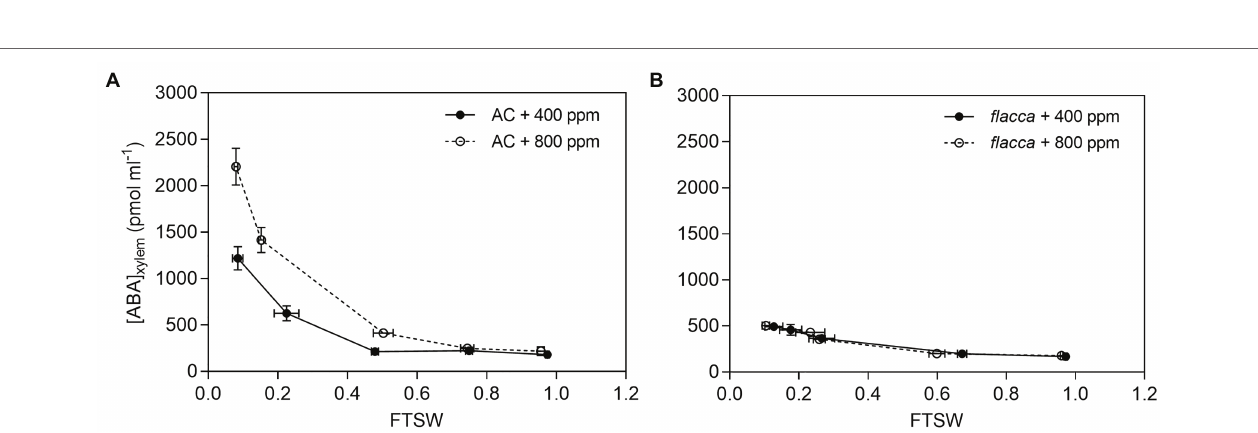
FIGURE 3 | Changes of leaf and root hydraulic conductance ( K leaf and K root ) of AC (A,C) and flacca ( B,D ; total samples = 17–20, N = 3–4) grown under ambient (400 ppm) and elevated (800 ppm) atmospheric CO 2 concentrations during progressive soil drying. FTSW represents the fraction of transpirable soil water. Closed circles indicate plants under 400 ppm CO 2 concentration, and open circles indicate plants under 800 ppm CO 2 concentration.